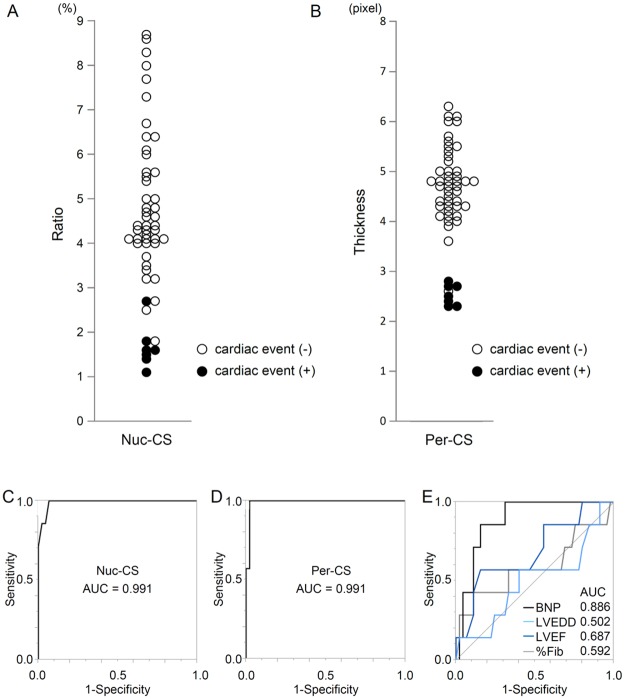
Distribution of Chromatin Score Values (Nuc-CS and Per-CS) and Cardiac Events.(A) Relationship between Nuc-CS and cardiac events. A white circle represents a patient who did not experience a cardiac event and a dark circle represents a patient who experienced a cardiac event. (B) Relationship between Per-CS and cardiac events. A white circle indicates a patient who did not experience a cardiac event and a dark circle represents a patient who experienced a cardiac event. (C) Receiver operating characteristic (ROC) curve analysis for Nuc-CS in predicting ventricular assist device (VAD) implantation 1 year after endomyocardial biopsy (EMB). (D) ROC curve analysis for Per-CS predicting VAD implantation 1 year after EMB. (E) ROC curve analysis for BNP (black), LVEDD (light blue), LVEF (dark blue), and %Fib (gray) in predicting VAD implantation 1 year after EMB. AUC, area under the curve; BNP, brain natriuretic peptide; LVEDD, left ventricular end-diastolic diameter; LVEF, left ventricular ejection fraction; %Fib, area of fibrosis within a specimen.